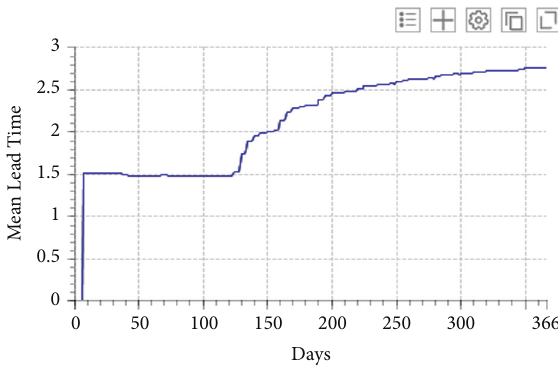
Figure 9: Mean lead time.